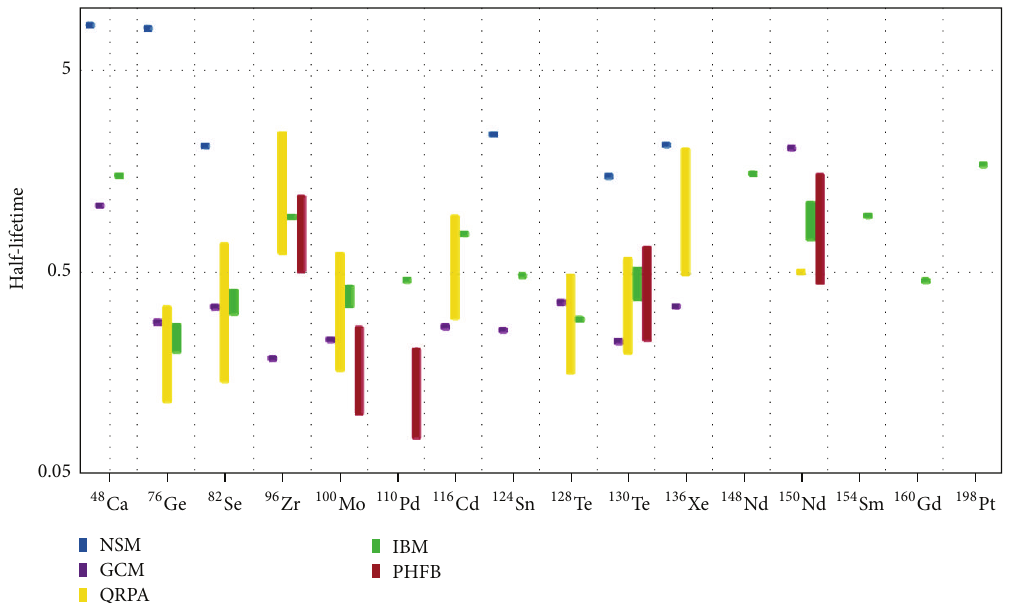
Figure 3: Ranges of theoretical 𝛽𝛽(0 ] ) half-lifetimes in unit of 10 26 yr, evaluated for |⟨𝑚 ] ⟩| = 50 meV and 𝑔 𝐴 = 1 . Discrepancies among different calculations are still of the order of a factor 2-3. Bars identify calculation ranges obtained within the same model, using different parameterizations. Dots refer to single calculations.